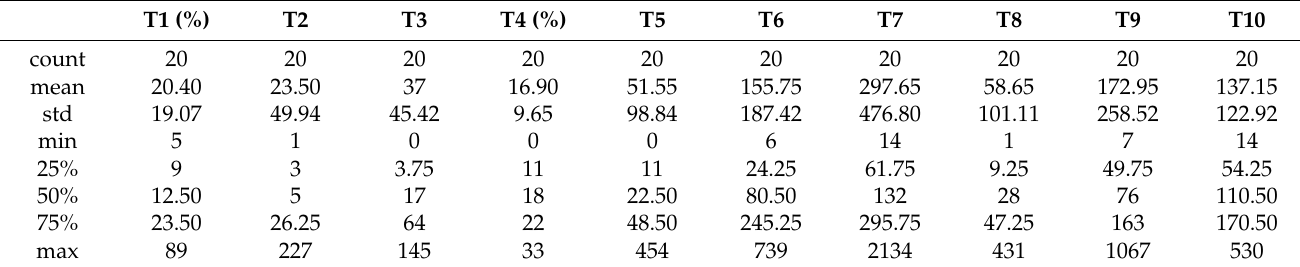
Table 6. Descriptive analysis for older technology